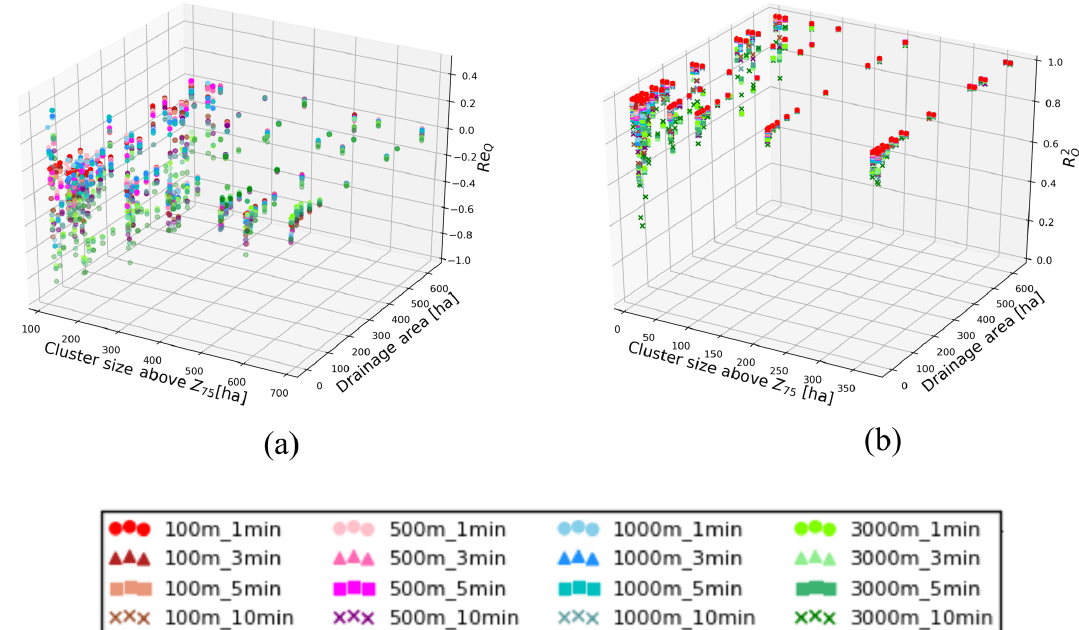
Figure 10. Re Q and R 2 as a function of cluster dimension above Z 75 and A d . Different colours and symbols indicates different rainfall Q resolution